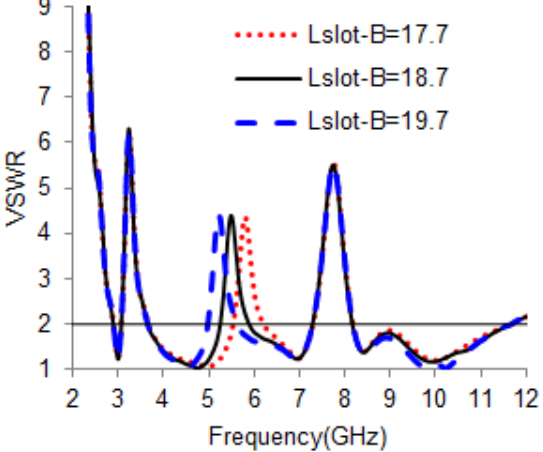
Figure 8: Measured and simulated VSWR for proposed hammer-shaped